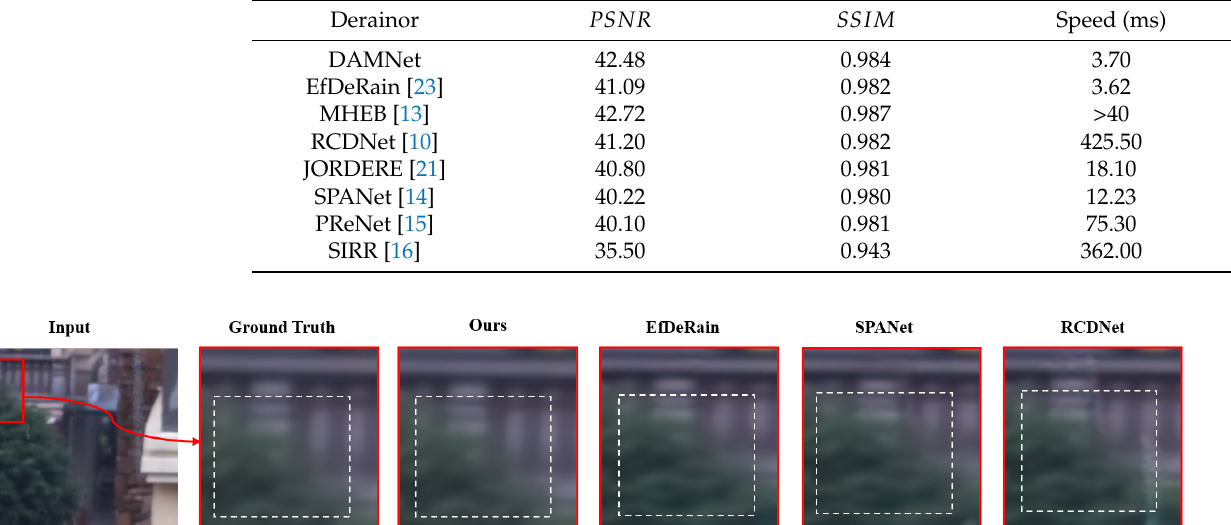
Figure 7. The deraining effects of the models above. The practical effects are seemingly the same, while DAMNet best maintains the original colour of the